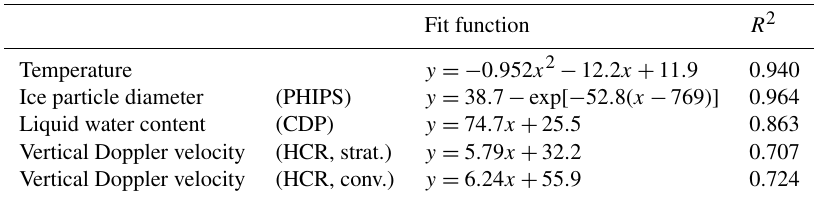
Figure 4. Histograms showing the absolute number of classified unrimed (blue) and rimed (red) particles during ACLOUD and SOCRATES as well as the riming fraction (relative percentage n rimed /n all , black, right axis) in correlation with different ambient parameters: Temper- ature (a) , area-eq. diameter of the underlying ice particle measured by PHIPS (b) , CDP liquid water content (c) and vertical HCR Doppler velocity in stratiform (d) and convective clouds (e) . HCR data are only available for SOCRATES. The dotted red line shows a fit to the riming fraction (right y axis). The corresponding fit parameters for all histograms are shown in Table 1. The statistical uncertainty bars correspond to the number of particles per bin ( n − 1 / 2 ). Only bins with n ≥ 20 are considered for the fit, others are shown in gray. Correlation plots with further parameters (CDP mean droplet diameter, ambient vertical velocity, relative cloud height, relative humidity), which show only a weak dependency, are shown in Fig. S3. Table 1. Fit parameters to the riming percentage histograms shown in Fig.